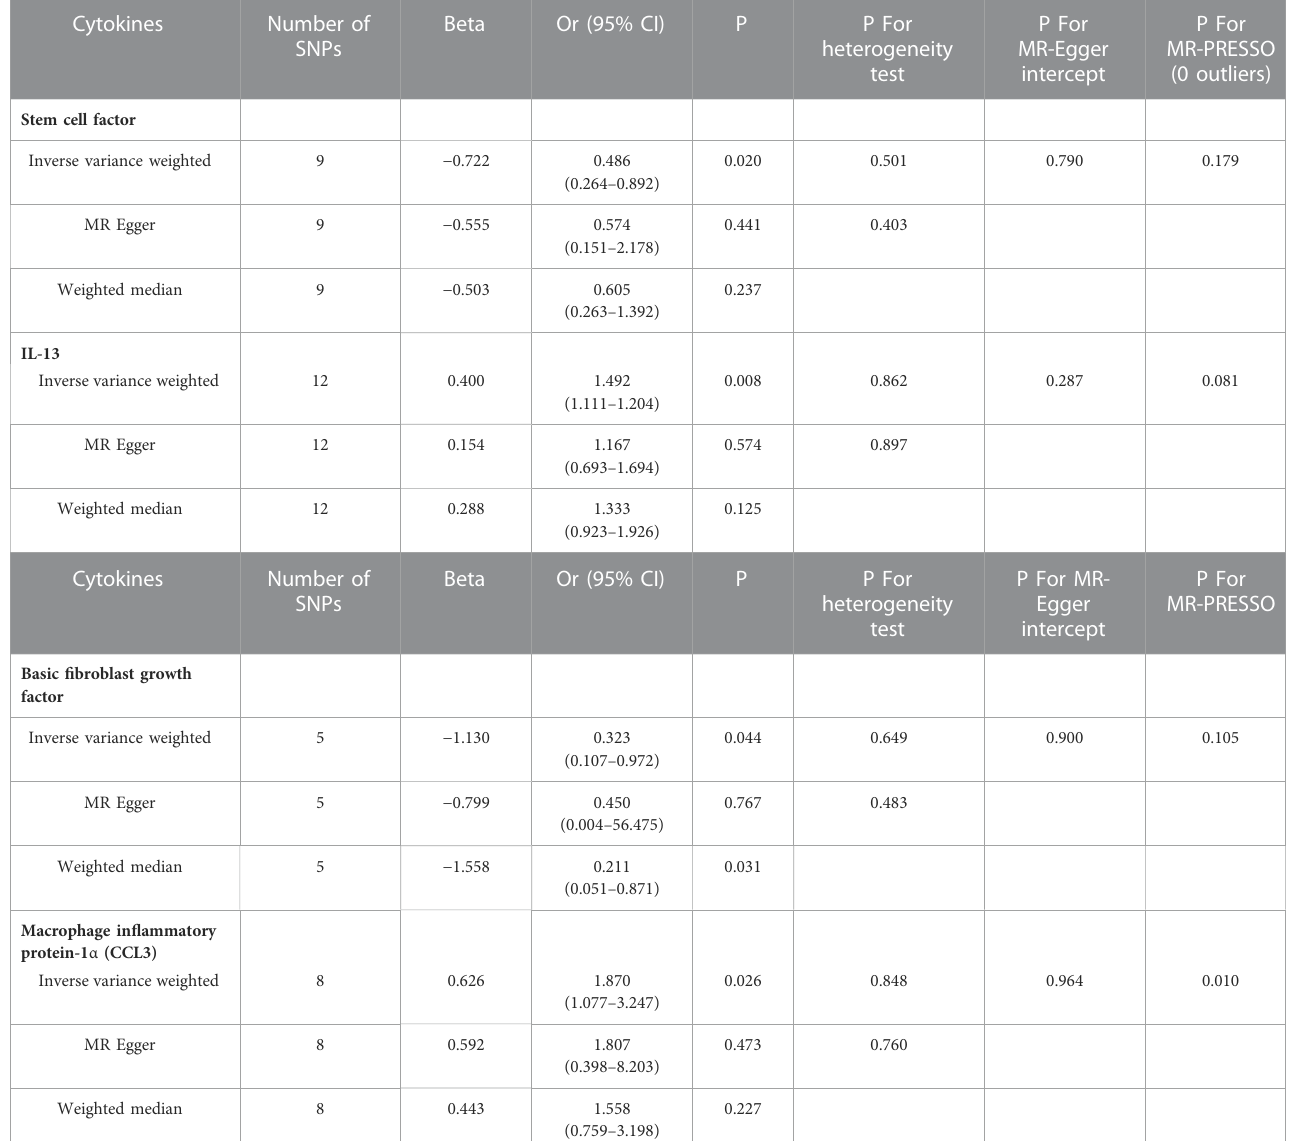
TABLE 2 Results of the MR study testing causal association between systemic in fl ammatory regulators and risk of